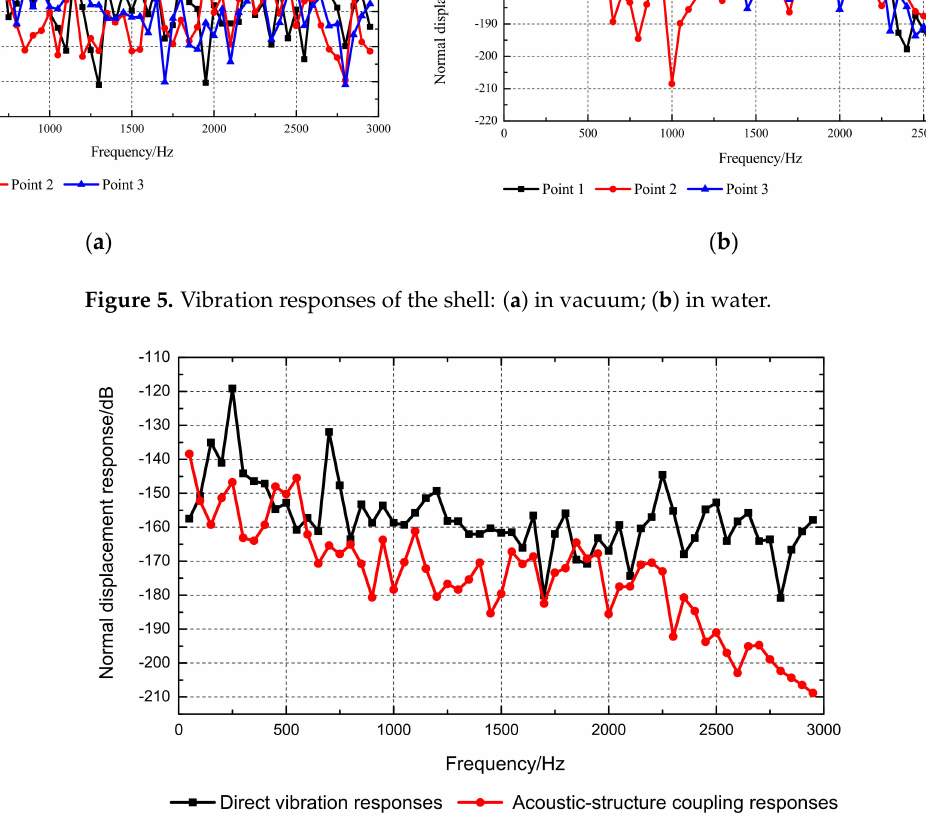
Figure 6. Comparison of responses of Point 3.